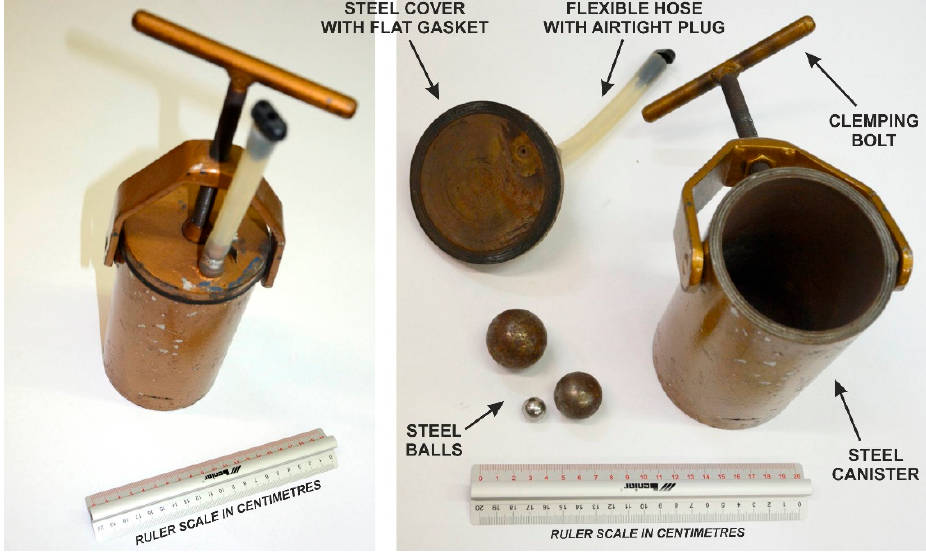
Figure 6. Airtight steel canister with steel balls for collecting coal samples.